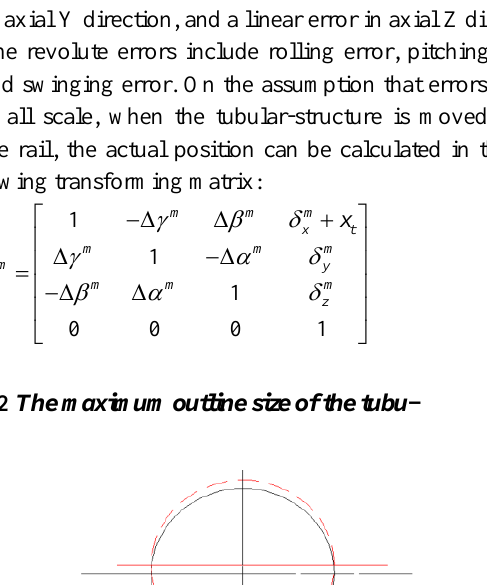
Figure 2 Principle structural configuration of the loading equipment